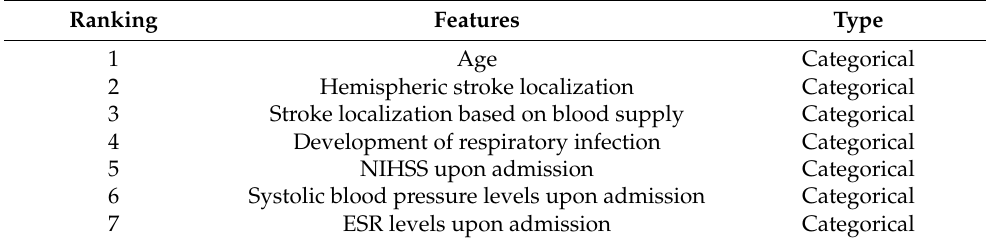
Table 4. Ranking according to the feature significance of the selected characteristics from the best ML model (RF) at the binary problem disability vs. non-disability.